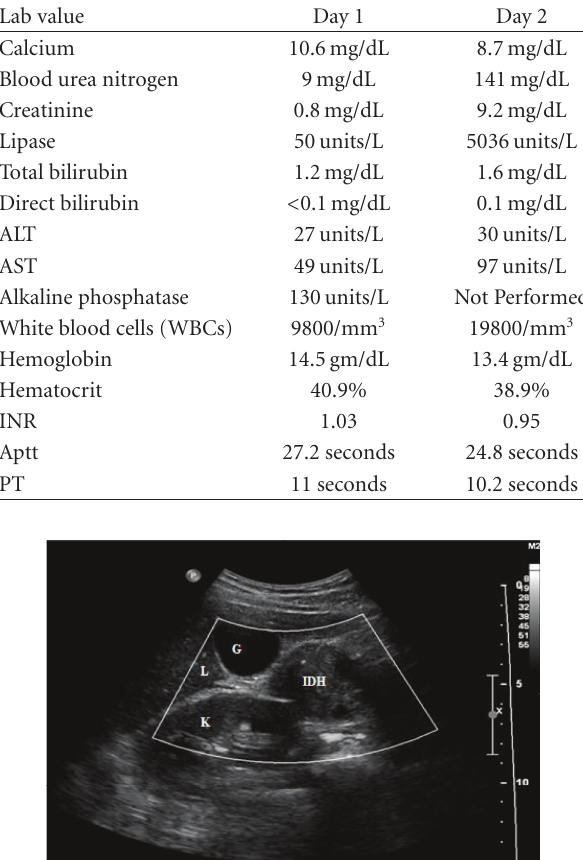
Table 1: Comparison of laboratory examinations of patient for day 1 and day 2 of presentations in emergency room.